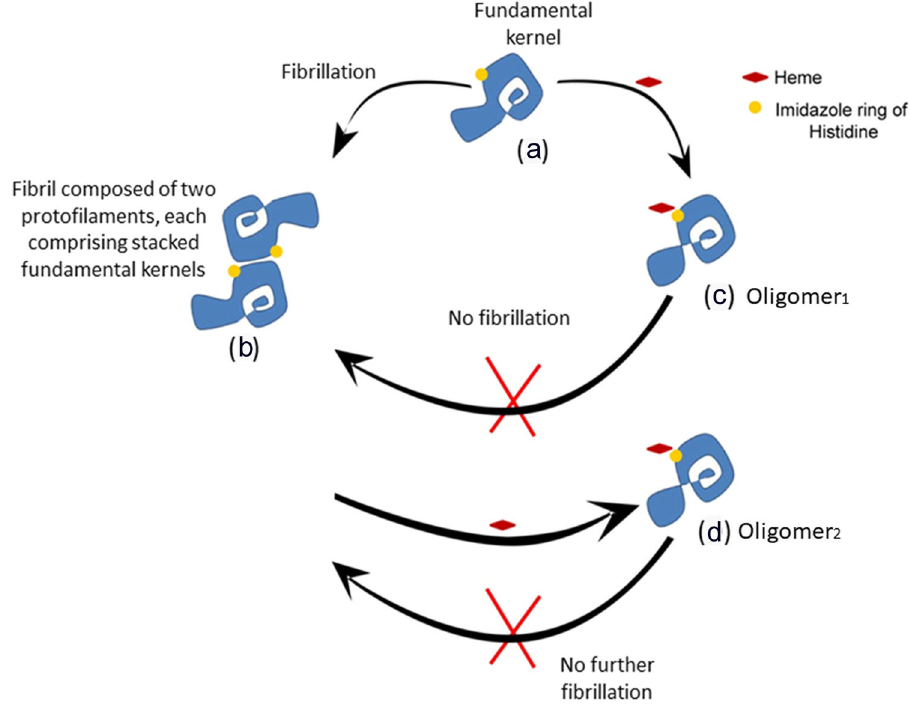
Fig. 7 Schematic representation of the mechanism of heme-mediated inhibition of α -Syn fi brillation. a The fi brillation of α -Syn 54,79 proceeds through the formation of an on-pathway ( fi bril-forming) fundamental proto fi lament kernel 10 which contains the β sheet Greek-key motif 9 (also termed as a bent β - arch structure) and serves as a ‘ building block ’ for fi brillation. b Fibril formation occurs via stacking of these kernels into proto fi laments which subsequently interlace at the steric zipper interface 10 to form mature fi brils. c Addition of heme at an initial stage stabilizes it into a twisted form (oligomer 1 ) which does not form fi brillar structures. d Addition of heme at a later stage (when fi brillation has already initiated) causes disassembly of α -Syn oligomers/ fi brils by inducing a twist/ distortion in the fundamental kernels resulting in a twisted Greek-key structural fold (oligomer 2